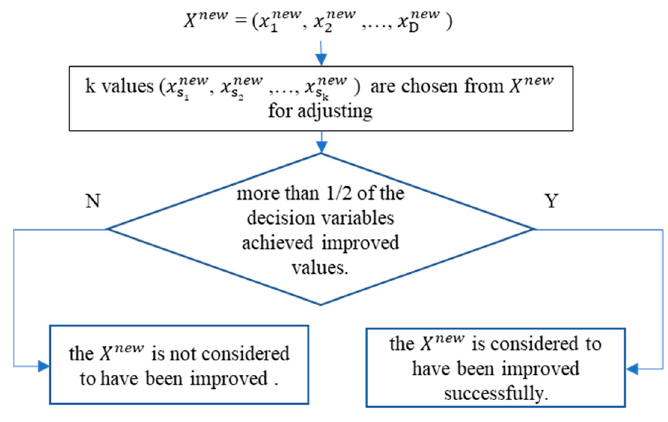
Figure 1. Flow chart that shows adjustments to X new